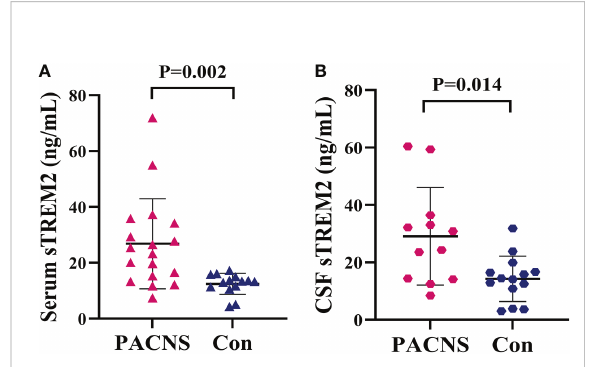
FIGURE 1 Elevated sTREM2 concentrations in the serum and CSF of PACNS patients. (A, B) sTREM2 concentrations in serum samples (n=18) and CSF samples (n=12) from the PACNS group were signi fi cantly higher than those in samples from the control group